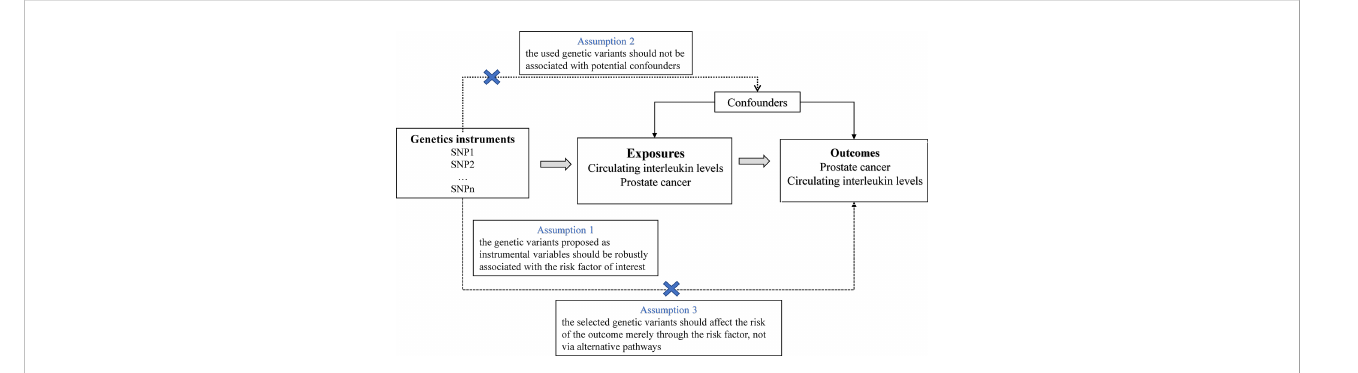
FIGURE 1 Overview and assumptions of the Mendelian randomization study